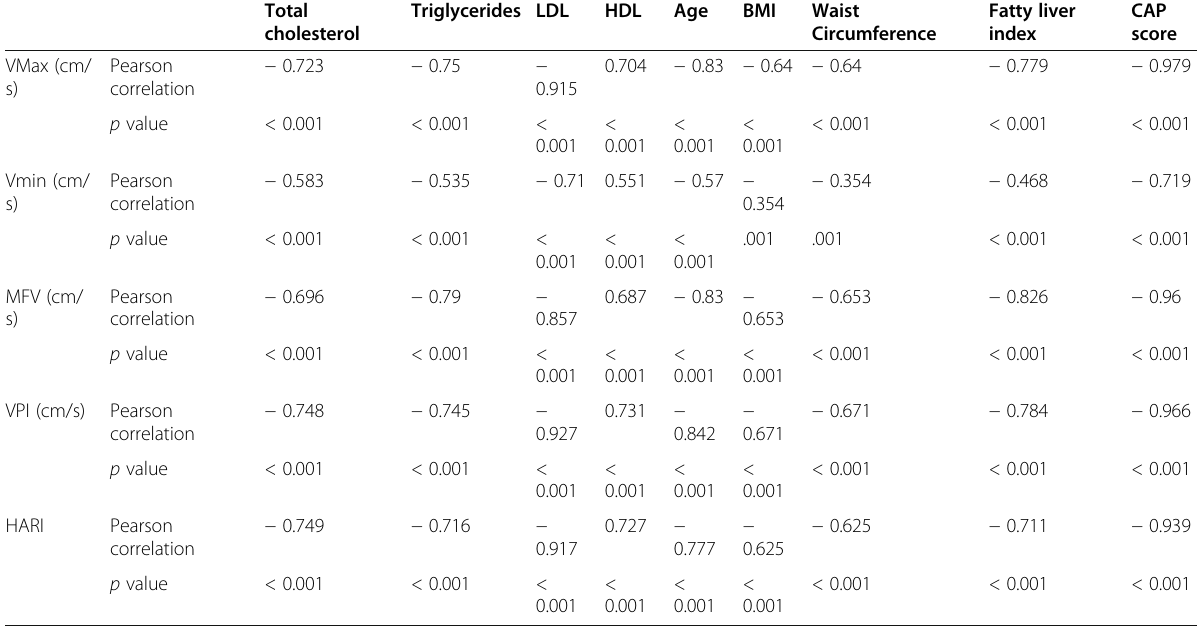
Table 4 Correlation between Doppler indices and significant variables in